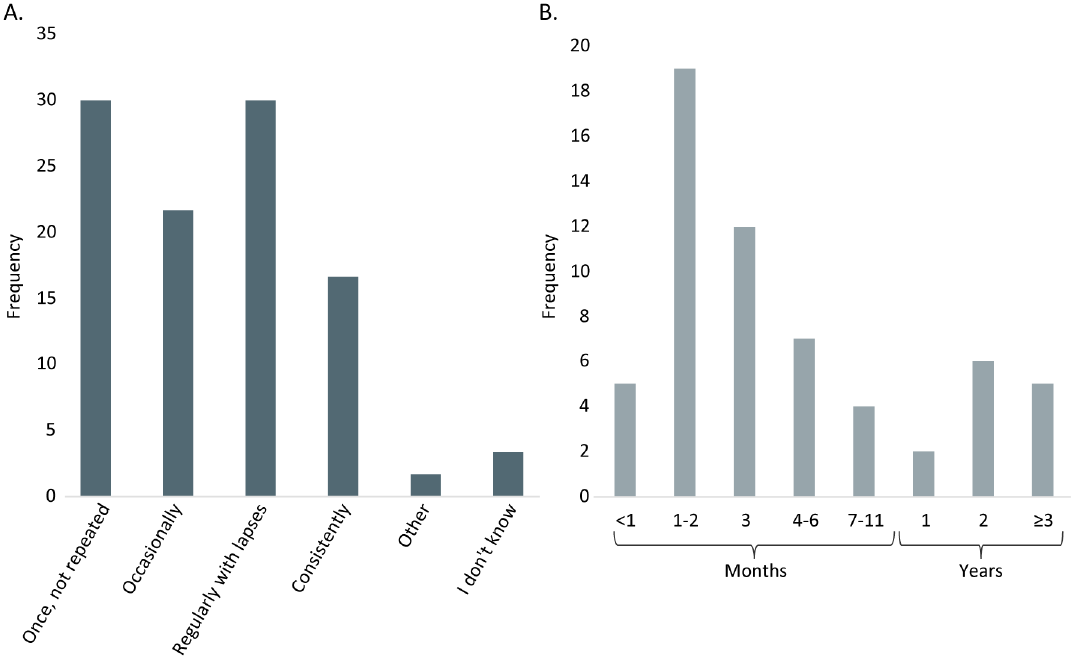
Figure 2. Use of the low carbohydrate ketogenic diet. ( A ): Consistency of use and ( B ): The longest time on the diet. Based on n = 60 responses. time on the diet. Based on n = 60